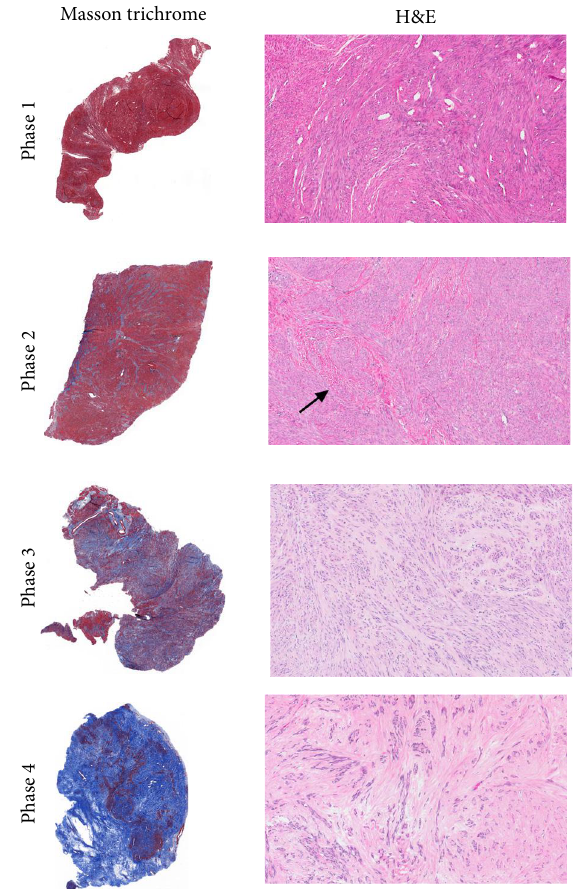
Figure 2: Fibroid Phases 1–4. Representative examples of the four phases of fibroid development are shown, with the Masson trichrome stain (1x image) on the left and the H&E stain of the same tumor (10x image) on the right. The progressive increase in blue staining collagen from Phase 1 to Phase 4 is well shown in the Masson trichrome stained sections. The corresponding H&E images on the right also demonstrate the virtual absence of collagen in the Phase 1 tumor, the appearance of interspersed pink collagenous fibers (arrow) in Phase 2, the more abundant pale pink collagenous stroma of Phase 3, and the predominance of pink, hyalinized stroma in Phase 4. Note also the abundance of microvessels (small ovoid spaces) in Phase 1 and the paucity of vessels in Phases 3 and 4.